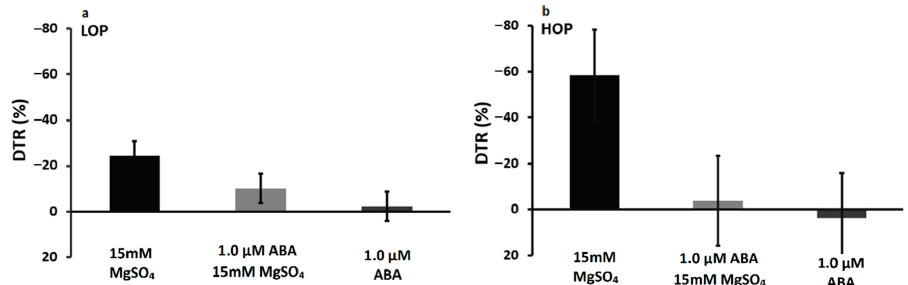
Figure 1. Decrease in the transpiration response (DTR) of intact plants of two maize near-isolines LOP ( a ) and HOP ( b ) at 32/26 °C and high VPD ~3.2 kPa. The treatments were (ABA (1.0 µM), MgSO 4 (15 mM), and a combination (ABA (1.0 µM) + MgSO 4 (15 mM))). The intact plants were grown hydroponically.